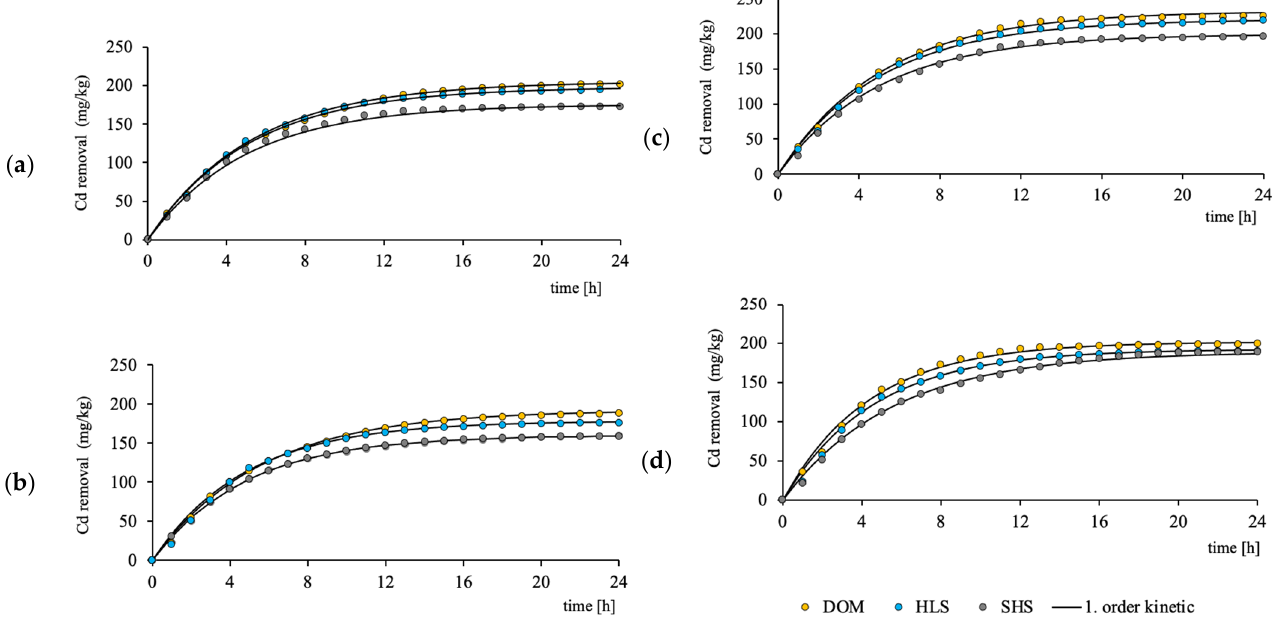
Figure 4. Cumulative Cd removal at 0.5 mL/min for ( a ) S1, ( b ) S2 and at 1.0 mL/min for ( c ) S1, ( d ) S2. Table 1. Kinetic parameters of cumulative Cd removal.